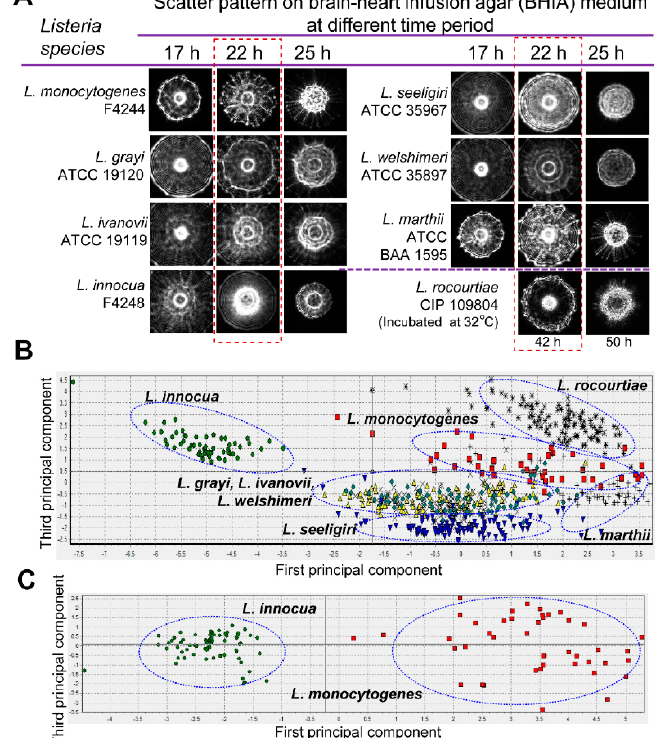
Figure 9. Optical scatter patterns of Listeria species and image analysis. ( A ) Colony scatter patterns were captured using bacterial rapid detection using optical light-scattering technology (BARDOT) at different incubation times for eight Listeria species on brain heart infusion agar plates. The rectangular selection with broken line depicts the optimal incubation time (22 h) that yielded differentiating scatter images when the colony size was 1.1 ± 0.2 mm diameter. ( B ) Principal component analysis of the eight Listeria species used to build the scatter image library. Blue oval selections indicate grouping of the Listeria species. ( C ) Principal component analysis of Listeria monocytogenes and Listeria innocua colony scatter images that were used to build a two-species scatter image library. The blue oval selections indicate the grouping of each Listeria species. Reprinted with permission from [191]. Published by Multidisciplinary Digital Publishing Institute.